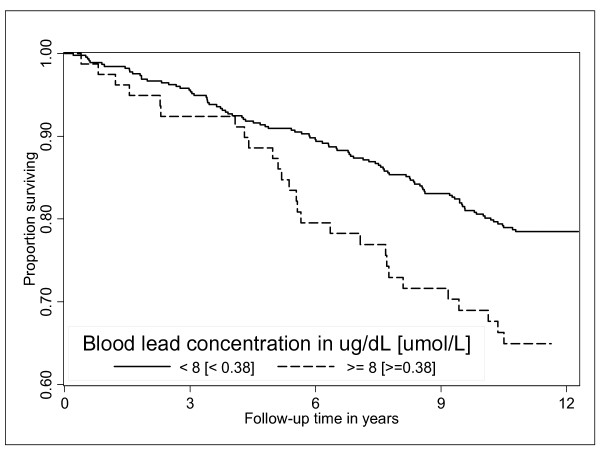
Cumulative survival with blood lead concentrations < 8 μg/dL (< 0.384 μmol/L), and ≥ 8 μg/dL (≥ 0.384 μmol/L) in women in SOF. Cumulative survival associated with blood lead concentrations < 8 μg/dL (< 0.384 μmol/L), and ≥ 8 μg/dL (≥ 0.384 μmol/L), in women in SOF lead ancillary study (Log rank test P < 0.007)